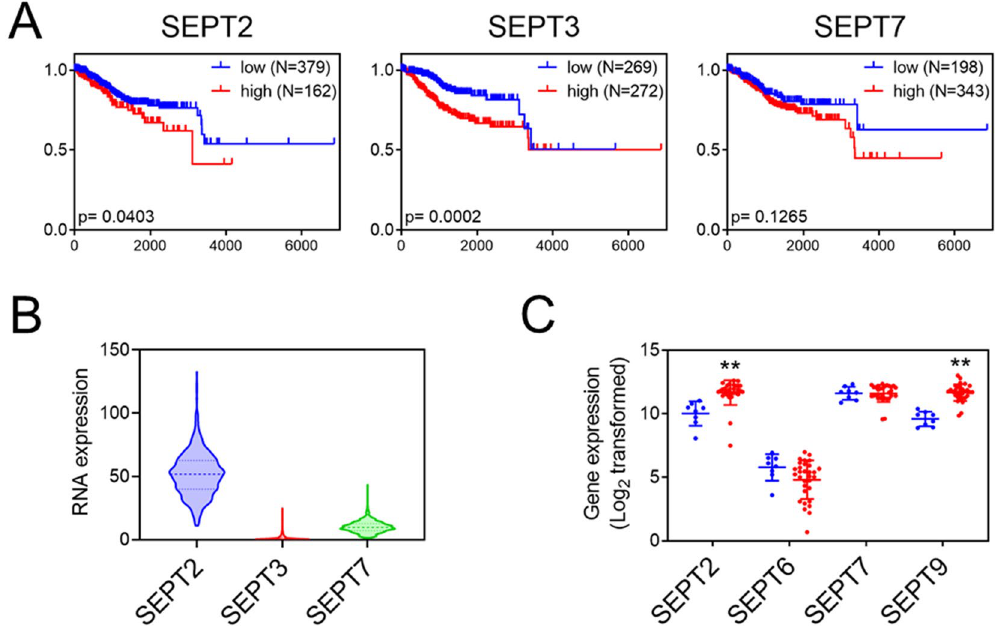
Figure 5. ( A ) Correlation of septins with survival rates of endometrial cancer patients was analyzed using the TCGA dataset. ( p < 0.05); x-axis: days; y-axis: survival fractions. ( B ) Relative expression of septin-2, -3 and -7 in endometrial cancers (TCGA dataset). ( C ) Relative gene expression of various septins was analyzed from the dataset (Wong-77-MAS5.0-u133p2), which contains gene expression profiling of microdissected cancer stroma samples from high grade serous ovarian cancer patients (red) and those from normal ovarian stroma (blue). ( ** p < 0.01, Student’s t -test vs. microdissec t ed normal ovarian